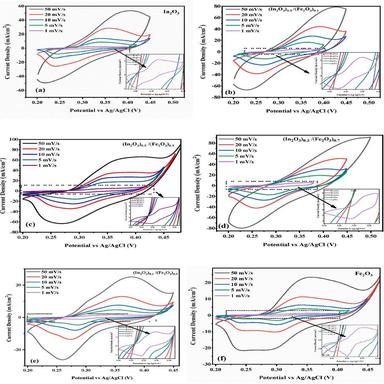
CV profiles for (a–f) all fabricated samples over Nickel foam at different scan rates (mV sec− 1 ).